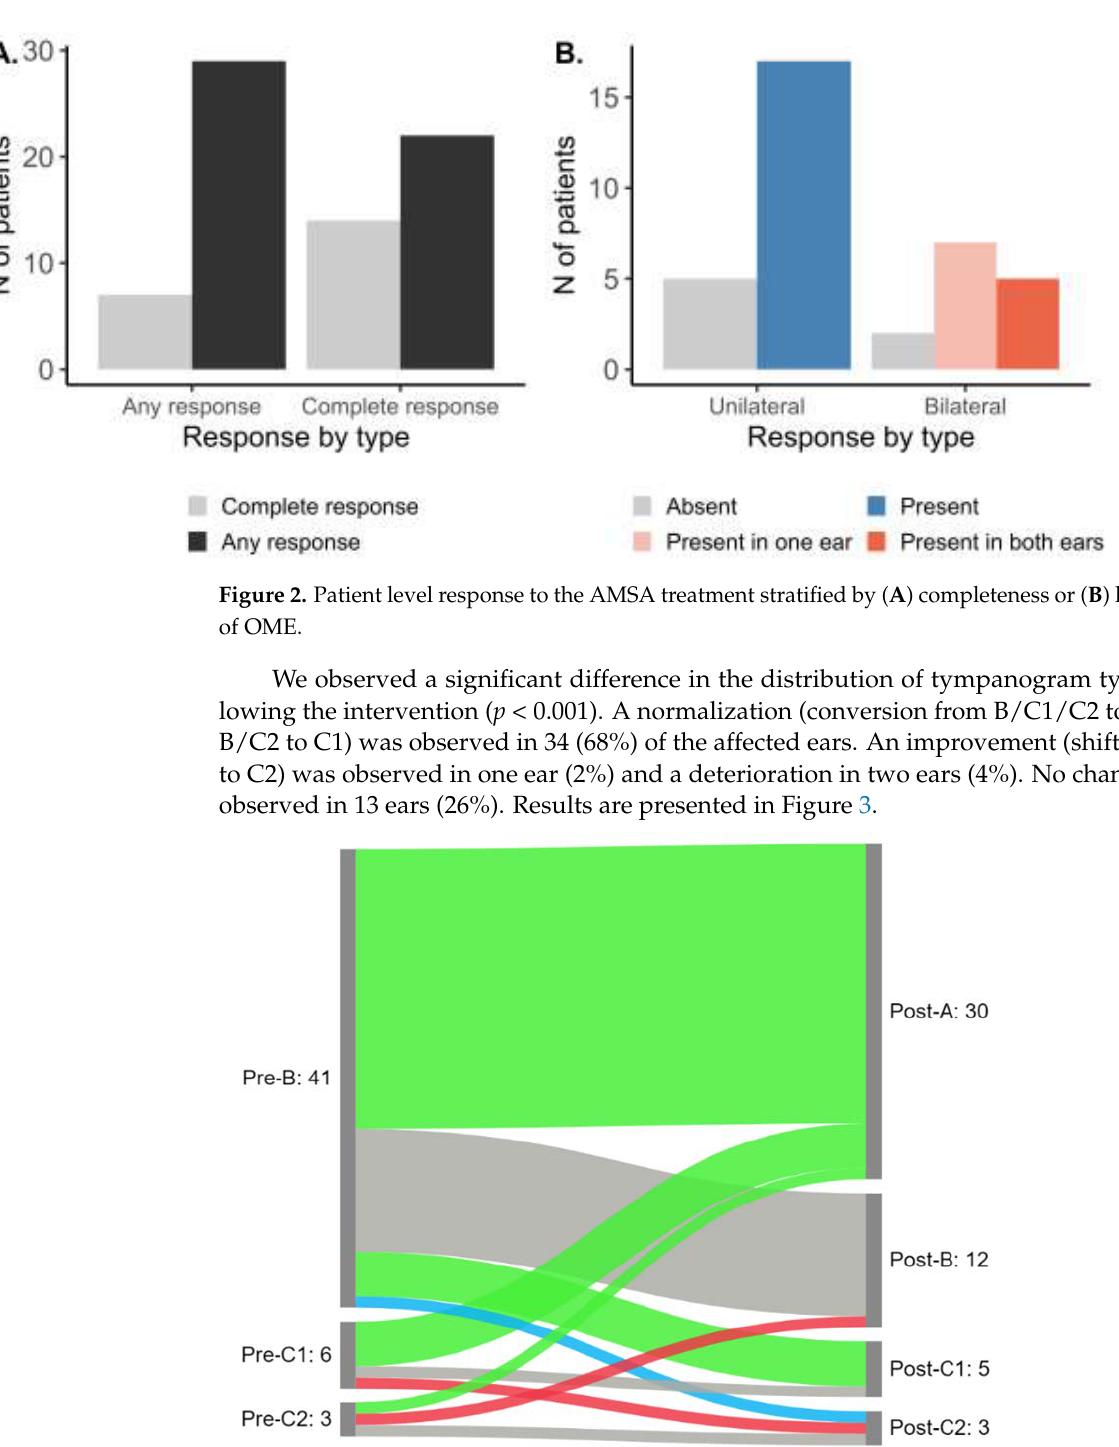
Figure 3. Sankey diagram summarizing patterns of tympanogram change following the intervention (green—normalization; blue—improvement; gray—no changes;